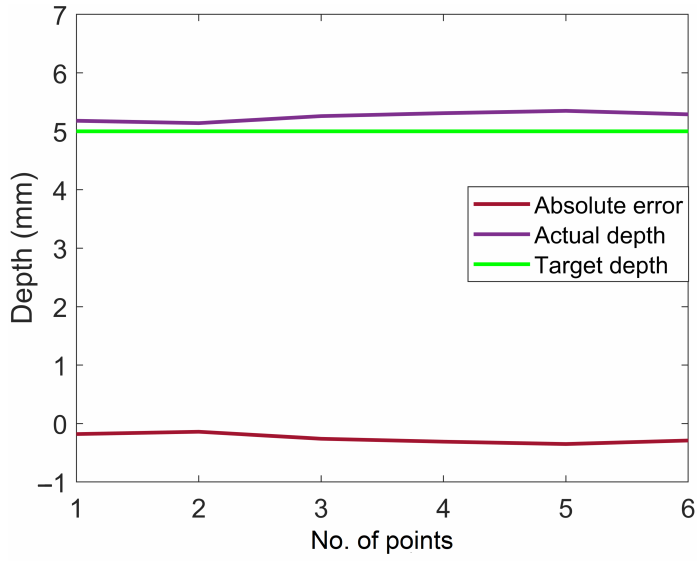
Figure 10. Absolute depth error in the normal trajectory generation on the flat surface.